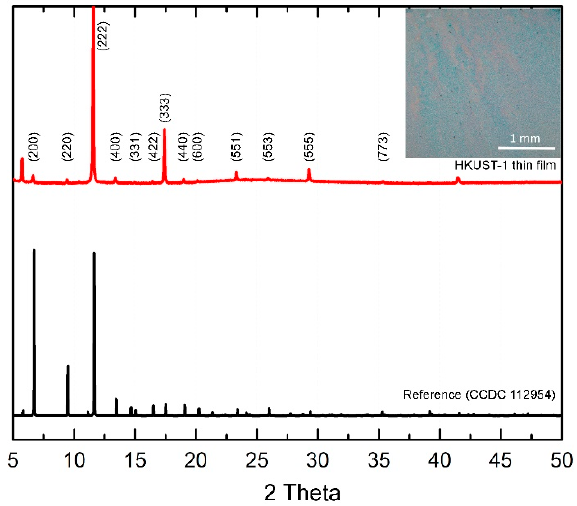
Figure 1. PXRD pattern of the synthesized HKUST-1 thin film and a reference compound (black curve, CCDC numb. 112954), with highlighted peaks from [31]. Inset: Optical image of the corresponding film. Scale bar, 1 mm.